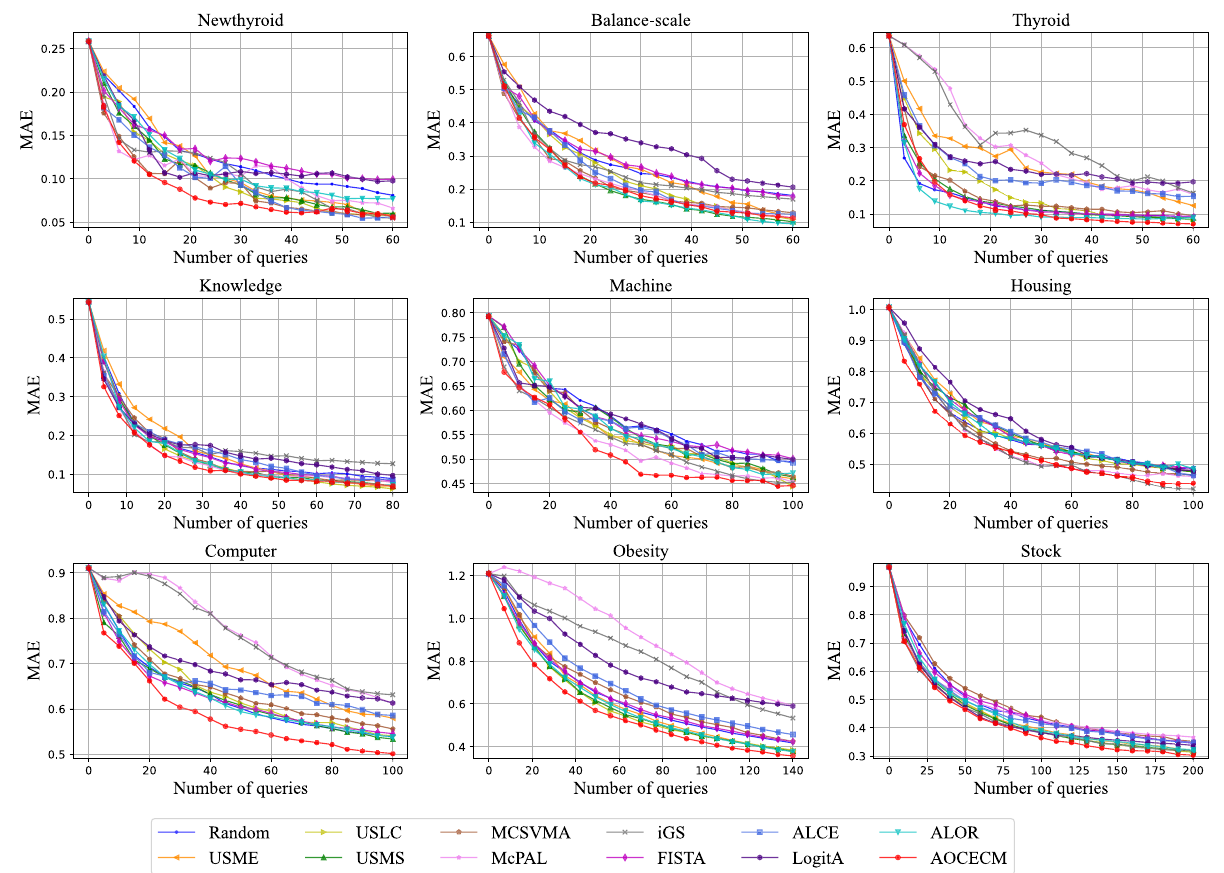
Figure 4. Learning curves of MAE for the twelve compared